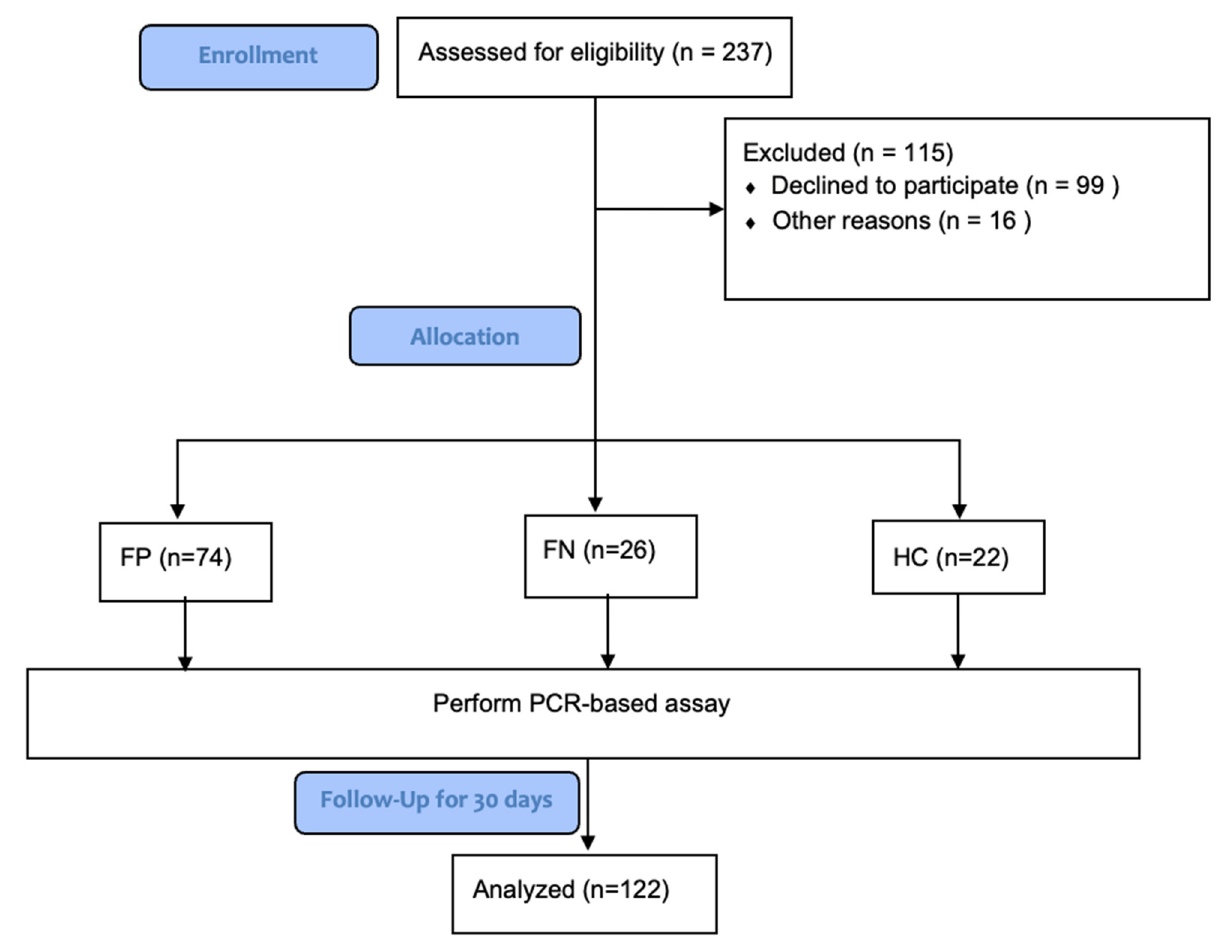
Figure 2. Study Flowchart.